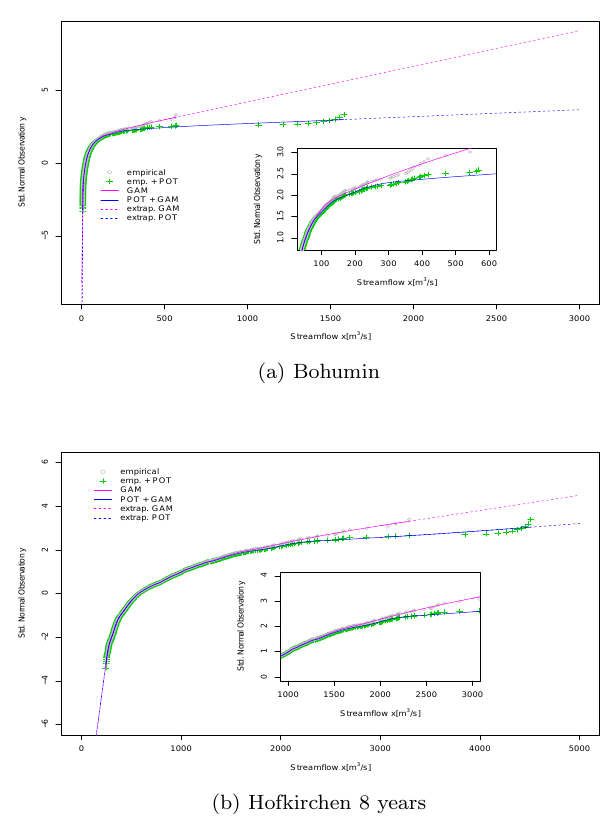
Fig. 3. Normalization of stream-flow values X at station Bo- humin (a) and at Hofkirchen – 8yr (b) . The range of obser- vations with and without including extreme values (labelled as “emp.+POT”, resp. “empirical”) has been extrapolated applying